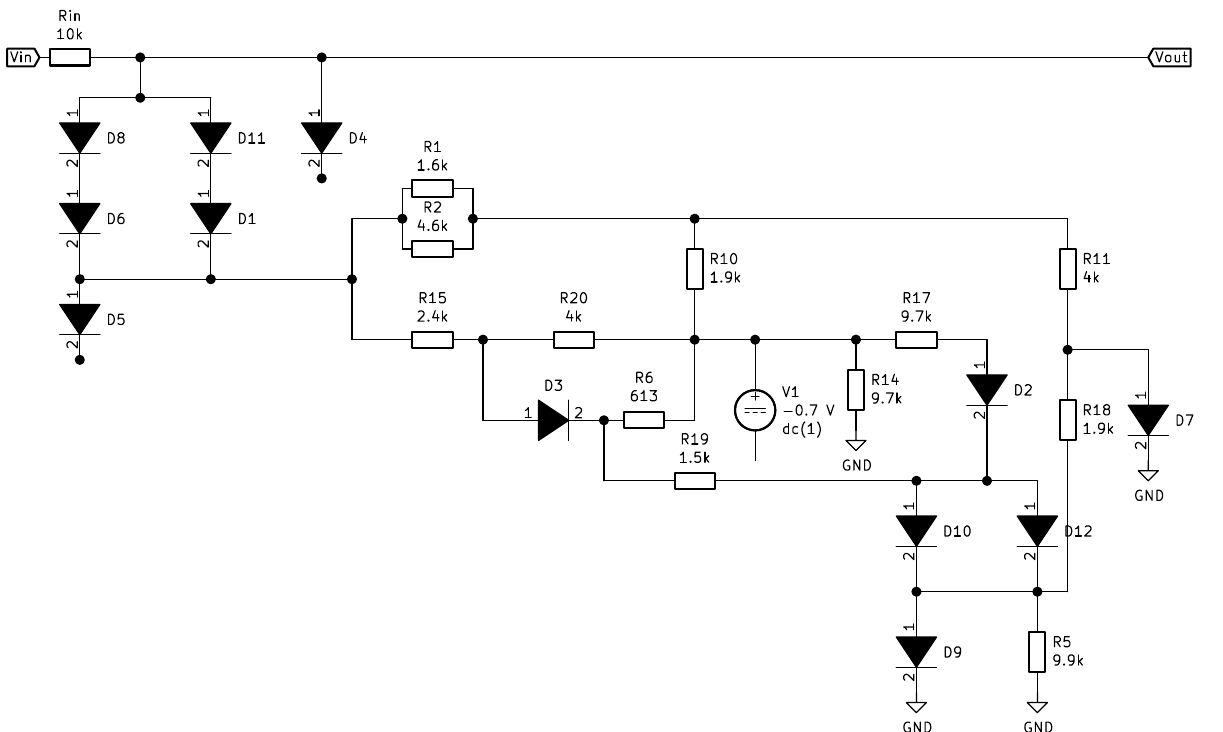
Figure 7. The evolved topology of failure-tolerant square root circuit (raw evolution result).